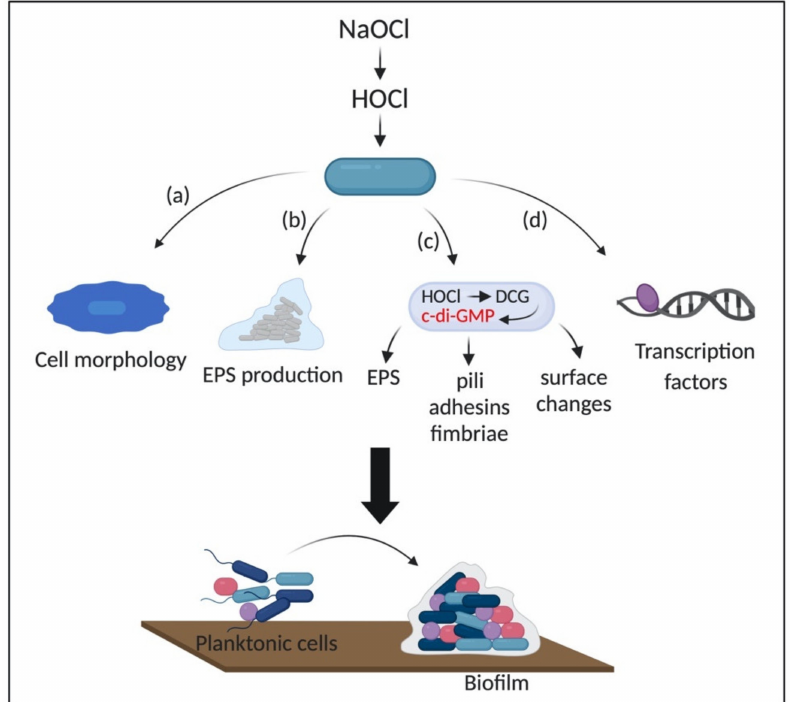
Figure 6. Possible mechanisms of HOCl biofilm stimulation in Gram-negative bacteria. HOCl induces ( a ) changes in cell morphology, which enhance the ability to adhere to surfaces; ( b ) increases the production of extracellular polymeric substance (EPS) matrix, increasing cell tolerance; ( c ) upregulates the production of c-di-GMP by DCGs; ( d ) regulates transcriptional regulators involved in HOCl-induced stress response. NaOCl: sodium hypochlorite; HOCl: hypochlorous acid; EPS: extracellular polymeric substance; DCG: diguanylate cyclase; c-di-GMP: